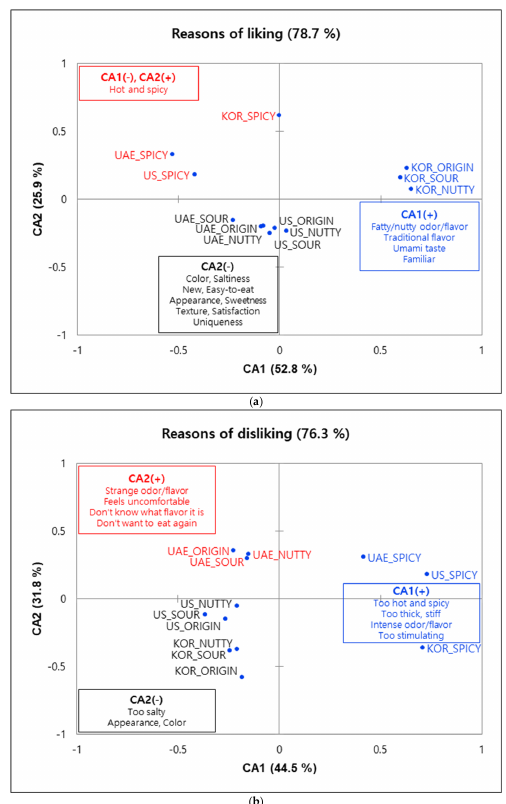
Figure 2. Correspondence analysis (CA) plot of ( a ) reasons for liking attributes and their corresponding salad dressing sample loadings; ( b ) reasons for disliking attributes and their sample loadings. Blue dots indicate the sample loadings evaluated by the consumers in the three countries and attributes in the boxes refer to the check-all-that-apply (CATA) liking and disliking terms.